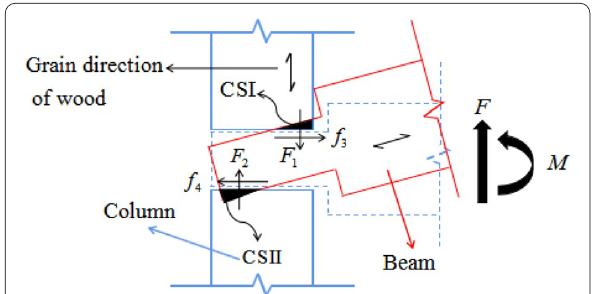
Fig. 2 The mechanical model of M&T joint